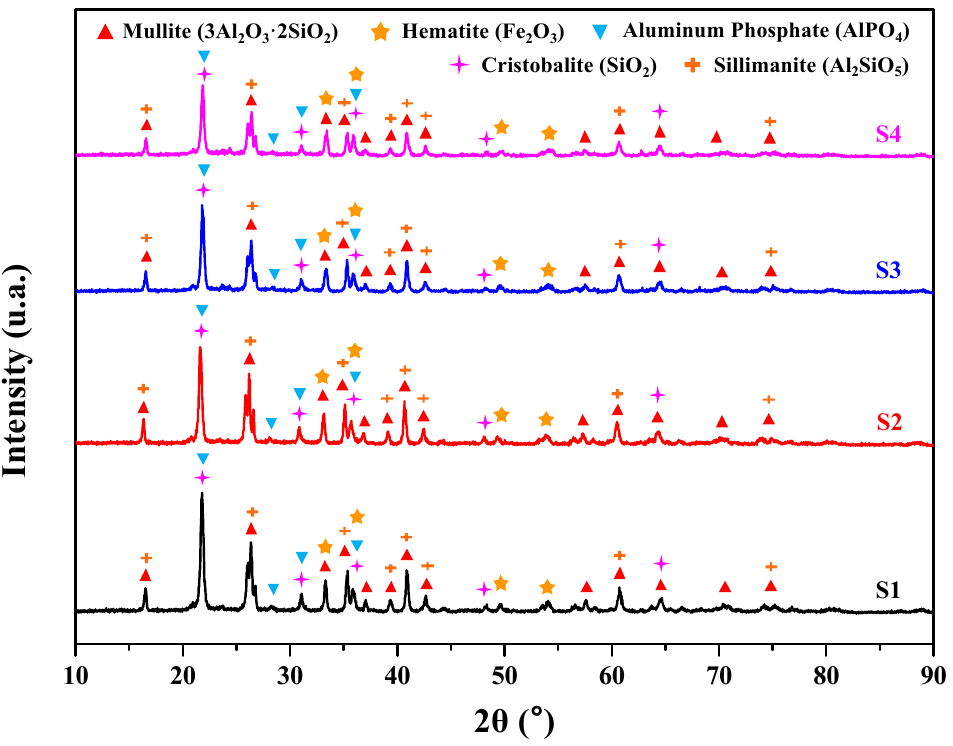
Figure 1. XRD patterns of the ceramic bricks with various sewage sludge contents sintered at 1250 °C for 40 min.